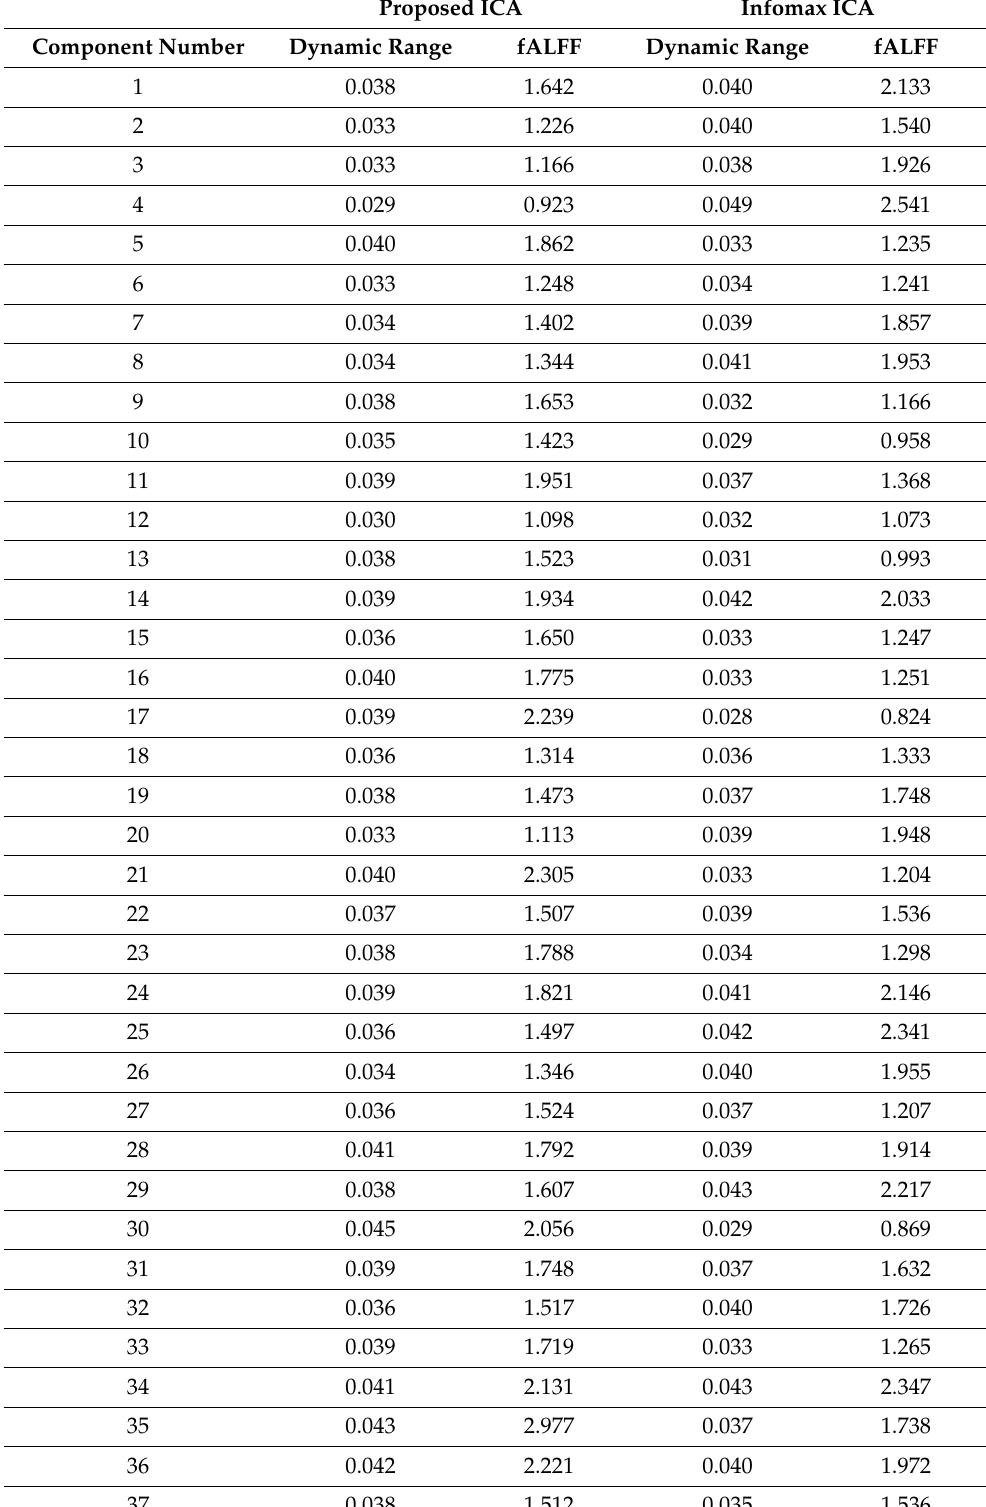
Table 3. Proposed ICA and Infomax ICA comparison with dynamic range and fALFF of extracted